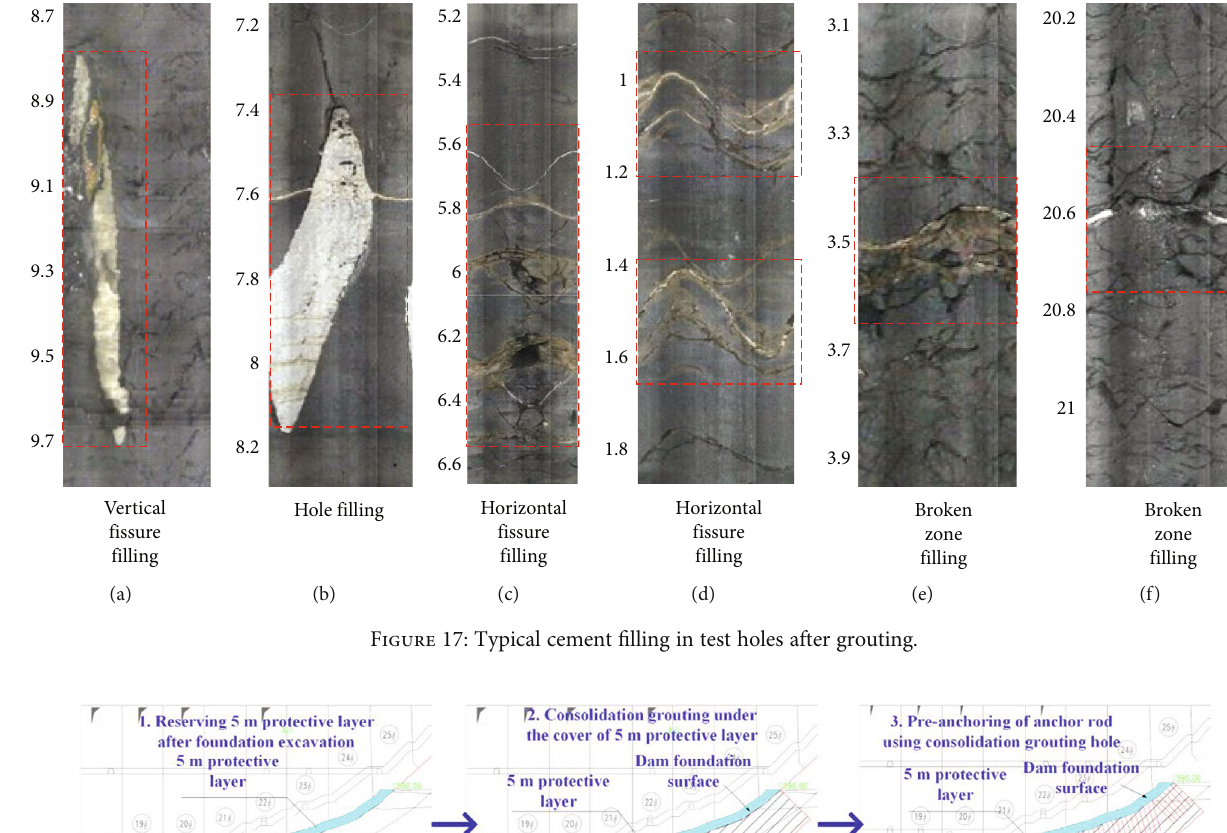
Figure 17: Typical cement fi lling in test holes after grouting.